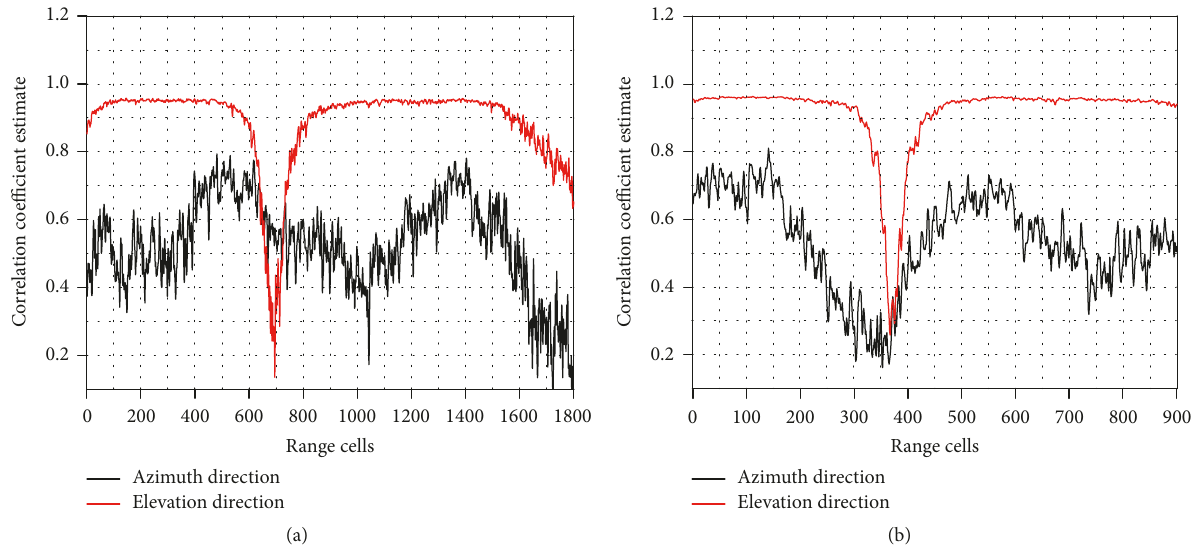
Figure 18: The texture cross-correlations between the difference and the sum channels for DS1 and DS2: (a) DS1. (b) DS2.